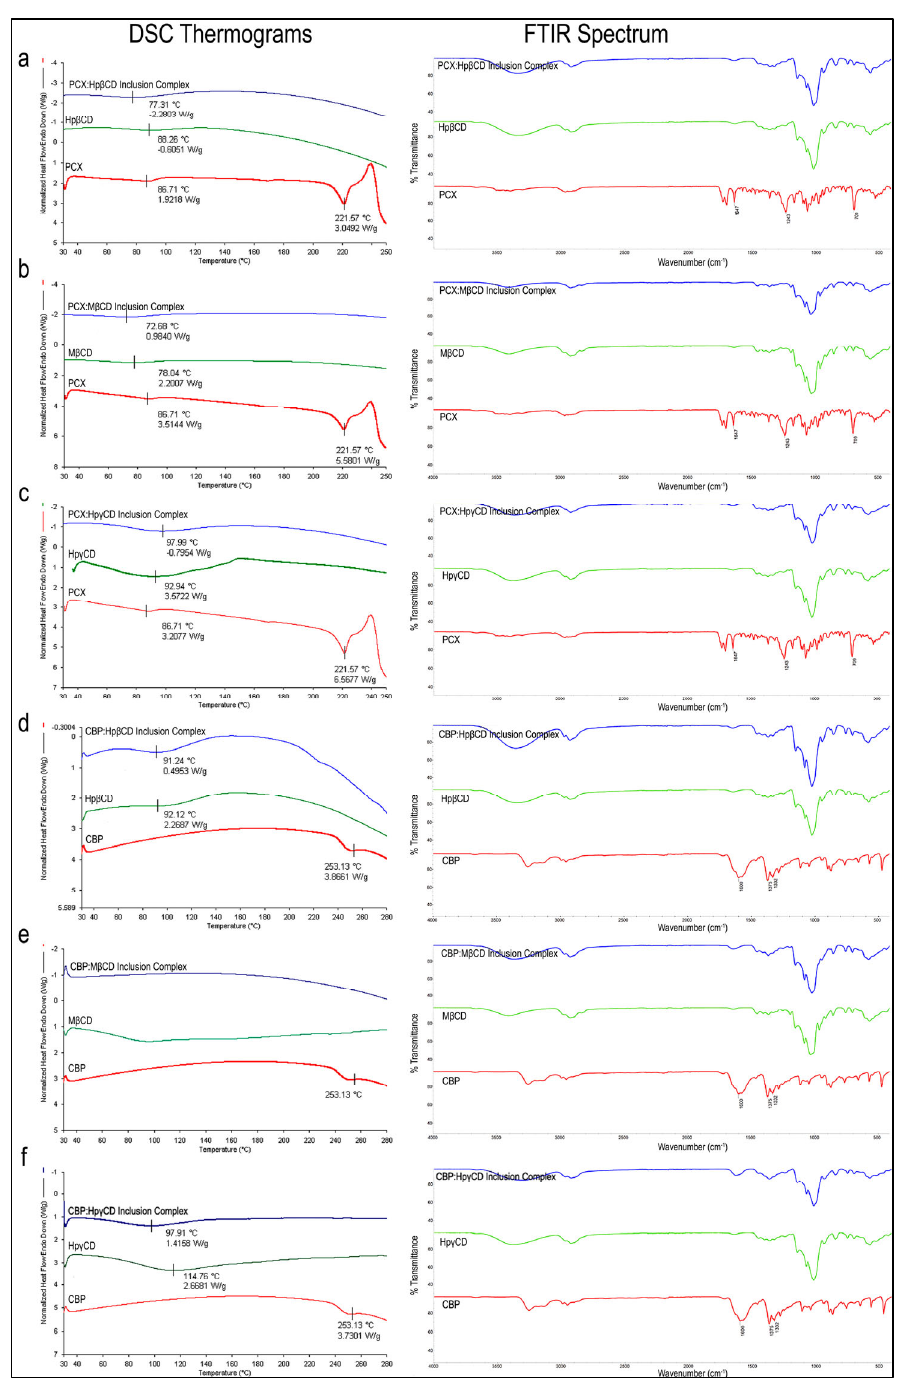
Figure 1. DSC thermograms and FTIR spectra of ( a ) PCX:Hp β CD, ( b ) PCX:M β CD, ( c ) PCX:Hp γ CD, ( d ) CBP:Hp β CD, ( e ) CBP:M β CD and ( f ) CBP:Hp γ CD inclusion